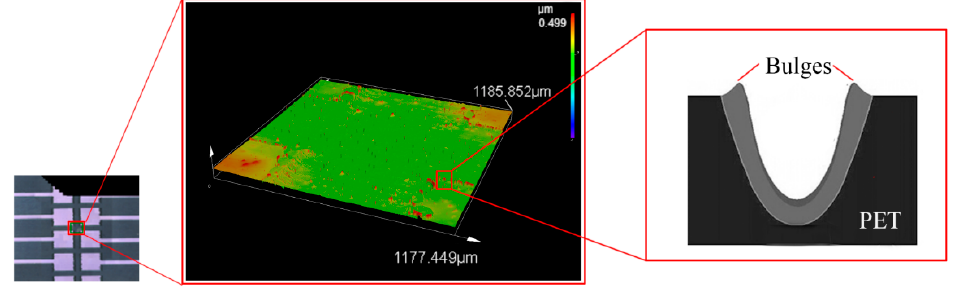
Figure 6. Laser confocal microscope measurement of the laser ablated surface.